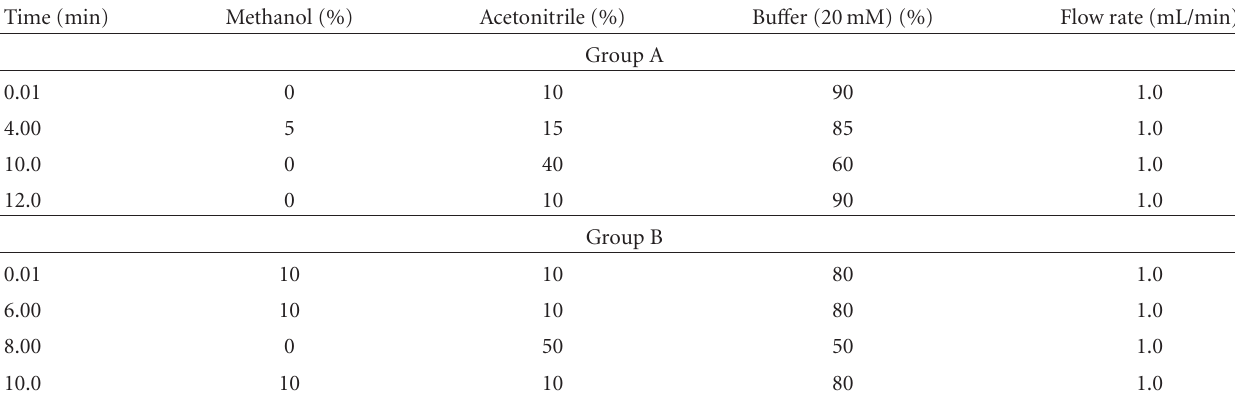
Table 2: Gradient mobile phase used during the analysis by HPLC-PDA for fluoroquinolones in group A and group B. Time (min) Methanol (%) Acetonitrile